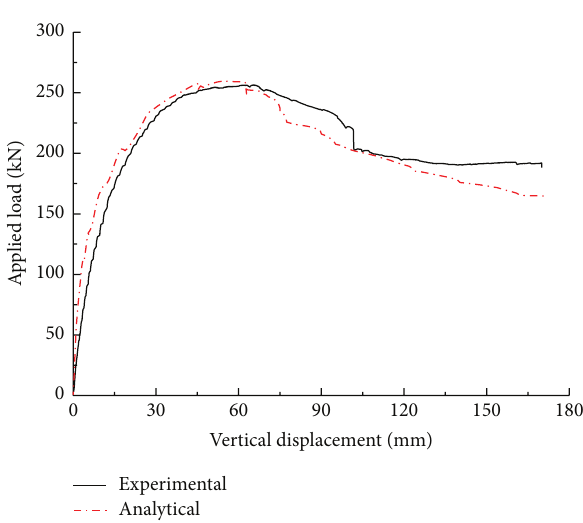
Figure 19: Applied load versus vertical displacement of the joint.